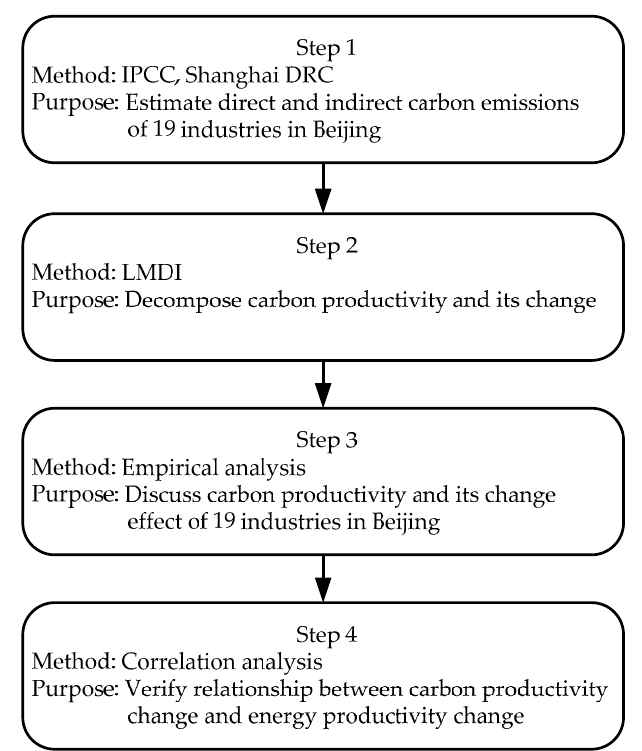
Figure 3. Overview of this study. IPCC: Intergovernmental Panel on Climate Change; DRC: Development and Reform Commission; LMDI: Log Mean Divisia Index.